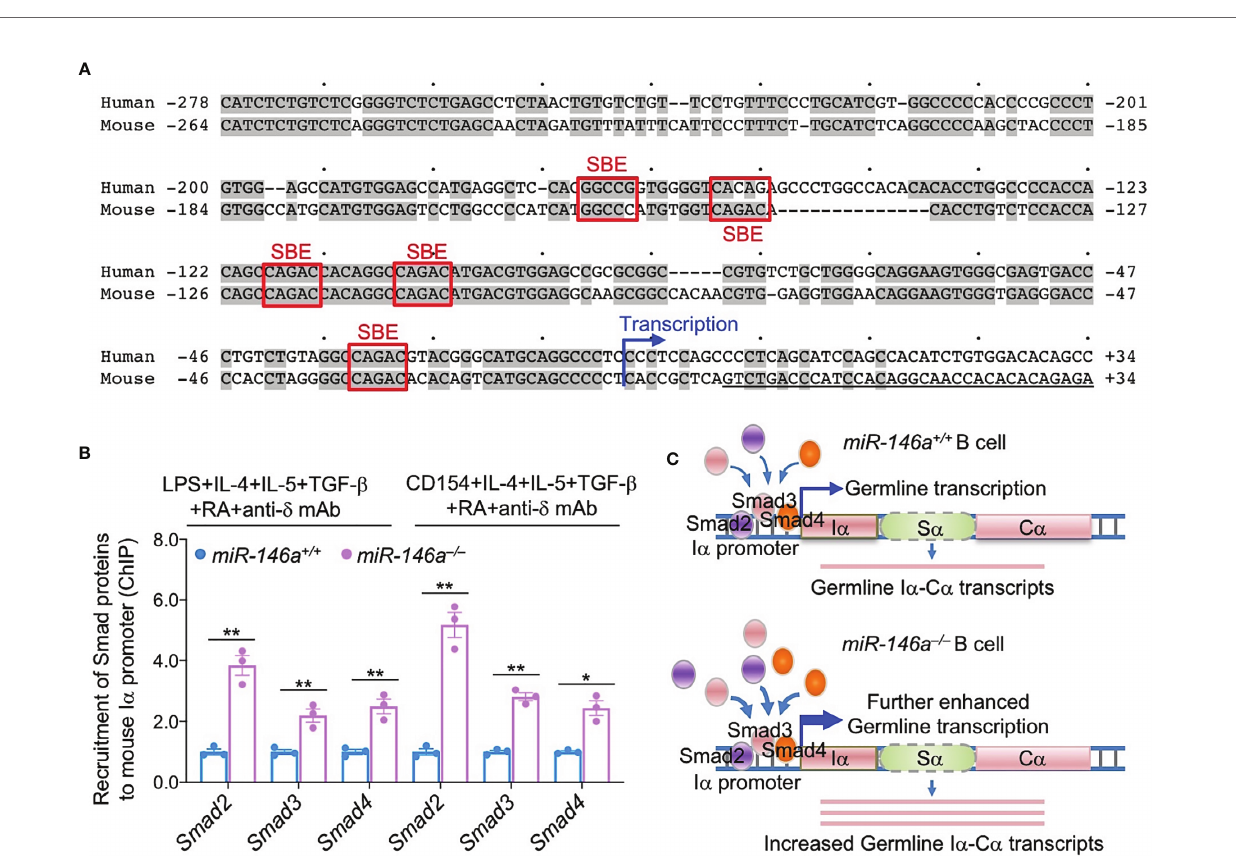
FIGURE 8 | miR-146a deletion results in increased Smad2, Smad3 and Smad4 recruitment to I a promoter. (A) Human and mouse I a promoters share fi ve SBEs, three of which are identical and conserved in mouse and human. (B) miR-146a – / – and miR-146a +/+ B cells were stimulated with LPS or CD154 plus IL-4, IL-5, TGF- b , anti- d mAb and RA for 72 h. The recruitment of Smad2, Smad3 and Smad4 to the I a promoter was analyzed by speci fi c ChIP assays. Data are mean ± SEM from three independent experiments. ** p < 0.01, * p < 0.05, unpaired t -test. (C) Cartoon depicting the increased availability of Smad2, Smad3 and Smad4 in miR- 146a – / – B cells and increased recruitment of these transcription factors to the IgH locus I a